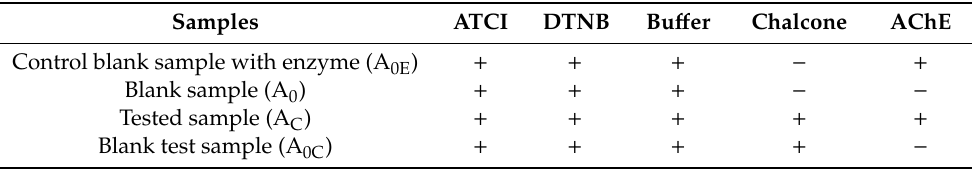
Table 6. The content of each sample in AChE in vitro